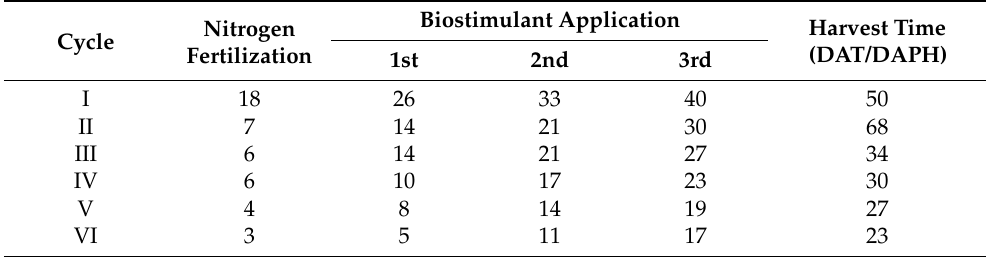
Table 1. Timing of the N fertilization, biostimulant application and harvests, in the different growing cycles, expressed as days after transplant (DAT, for the first cycle) and days after the previous harvest (DAPH, from the second cycle onwards) (further details in Di Mola et al. [25]). Biostimulant Application Harvest Time Nitrogen Cycle (DAT/DAPH)1st 2nd 3rd Fertilization I 18 26 33 40 50 II